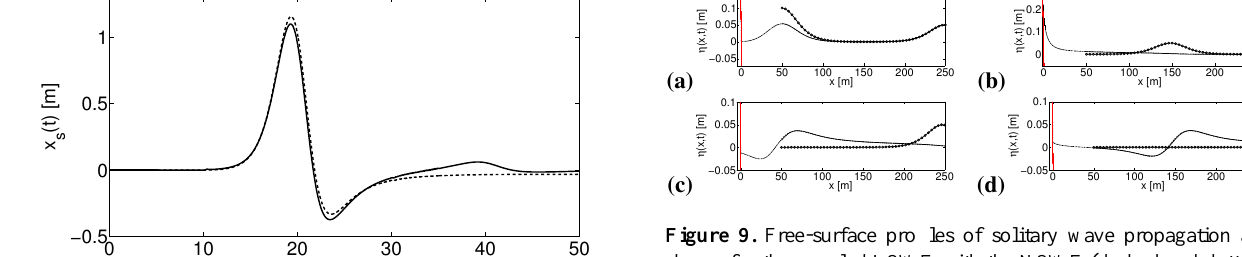
Fig. 8. Comparison of the shoreline movement of Choi et al. (2011) (dashed line) and the LSWE with an EBC simulation (solid line) for solitary wave case.